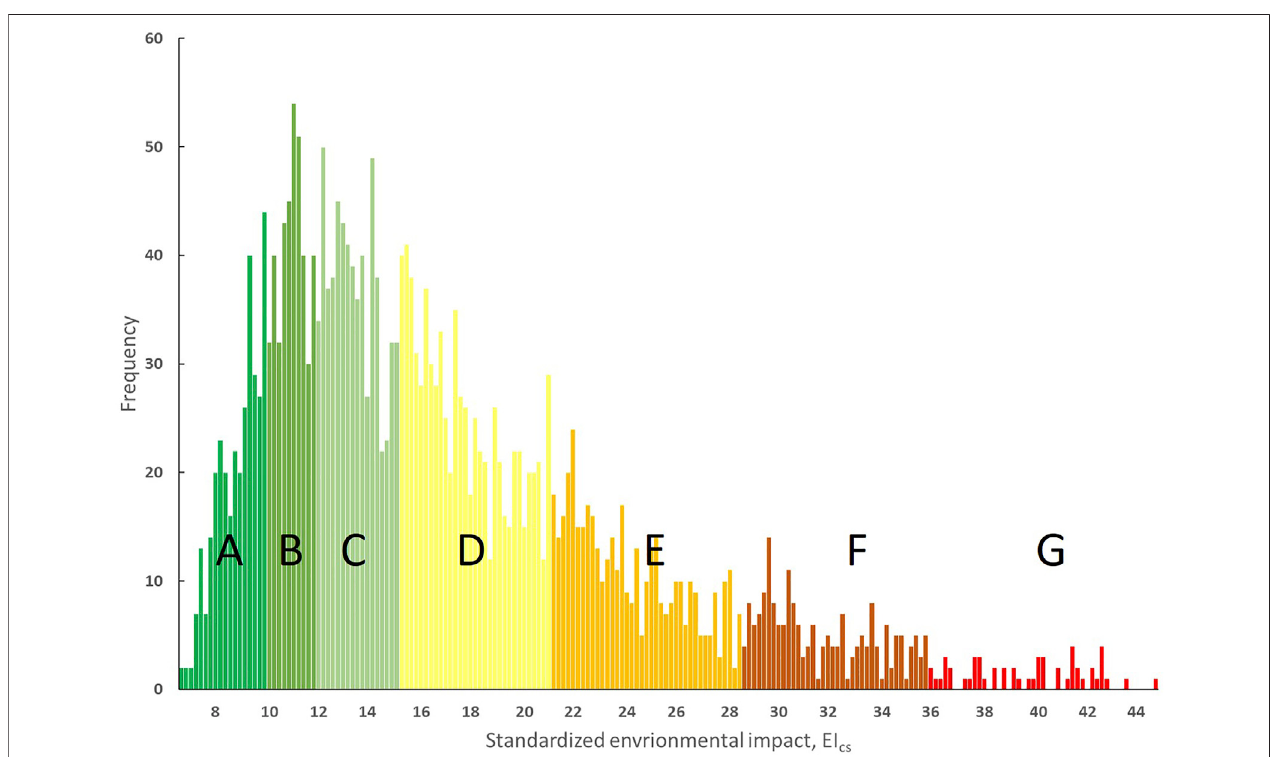
FIGURE 3 | Histogram showing frequency of samples with different standardized Eco Impacts (EI cs ) from the market analysis.